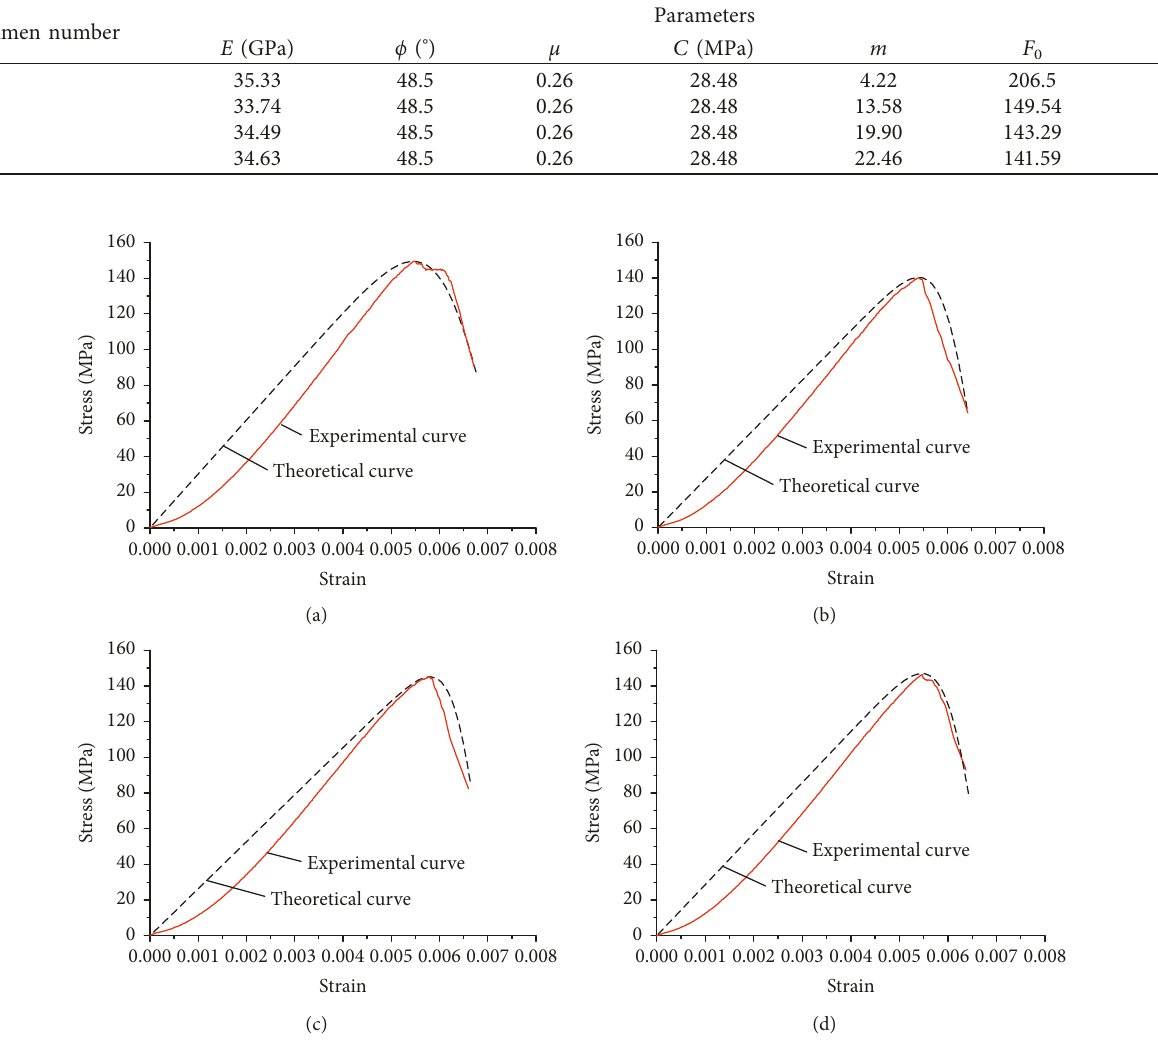
Figure 12: Contrast diagram between the theoretical and experimental curves of granite specimen groups. (a) Specimen group 1-1. (b) Specimen group 2-4. (c) Specimen group 3-2. (d) Specimen group